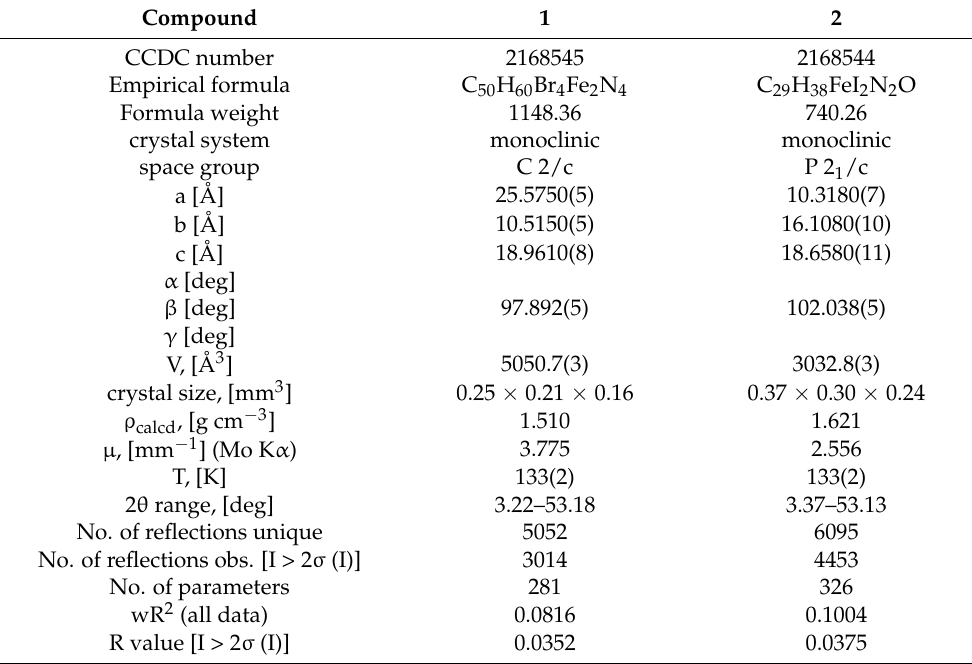
Table 1. Crystallographic data of the compounds 1 and 2